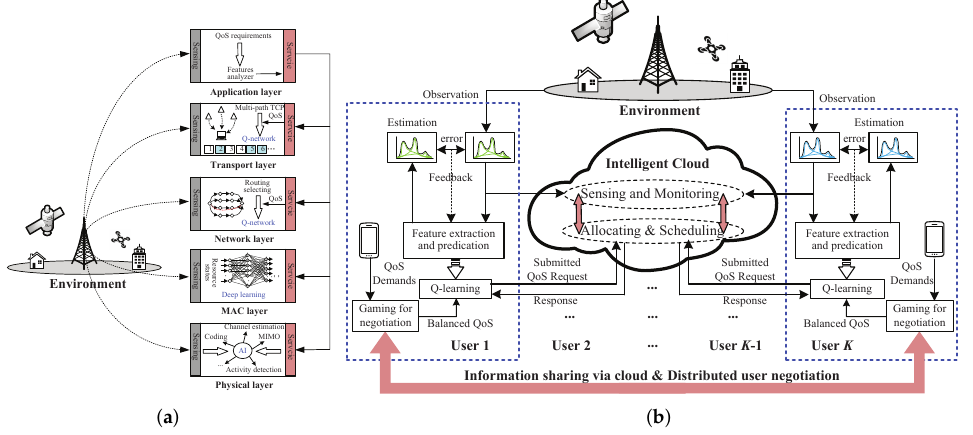
Figure 4. The model of the distributed AI: ( a ) the vertical dimension; ( b ) the horizontal